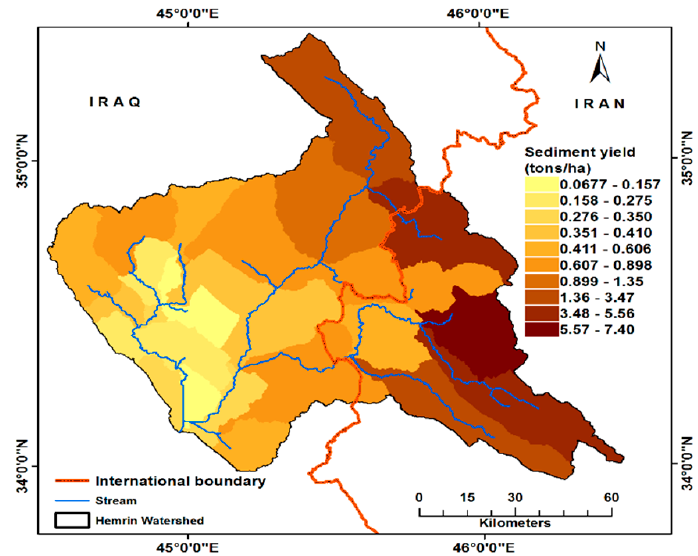
Figure 25. Result of senario-1 (M-1) of sediment mitigation.